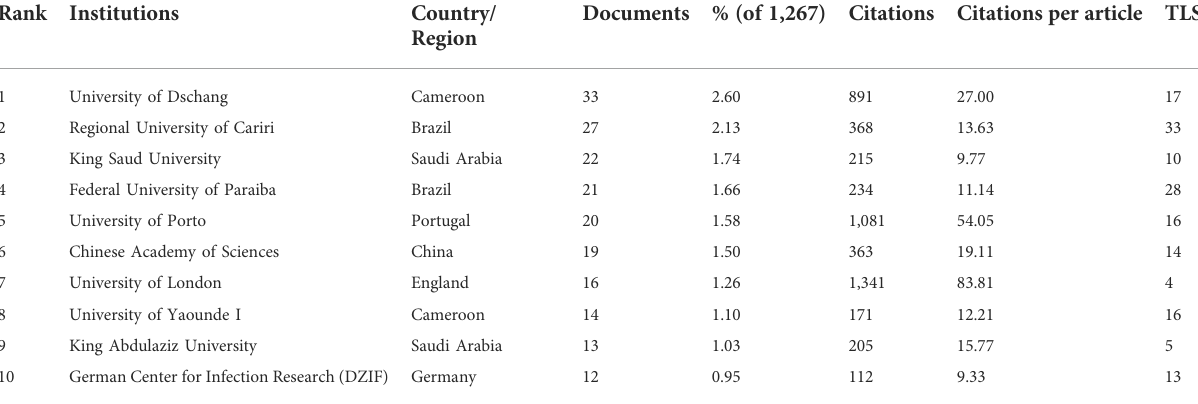
TABLE 1 The top 10 productive institutions related to resistance of natural products to MDR bacteria. Rank Institutions Country/